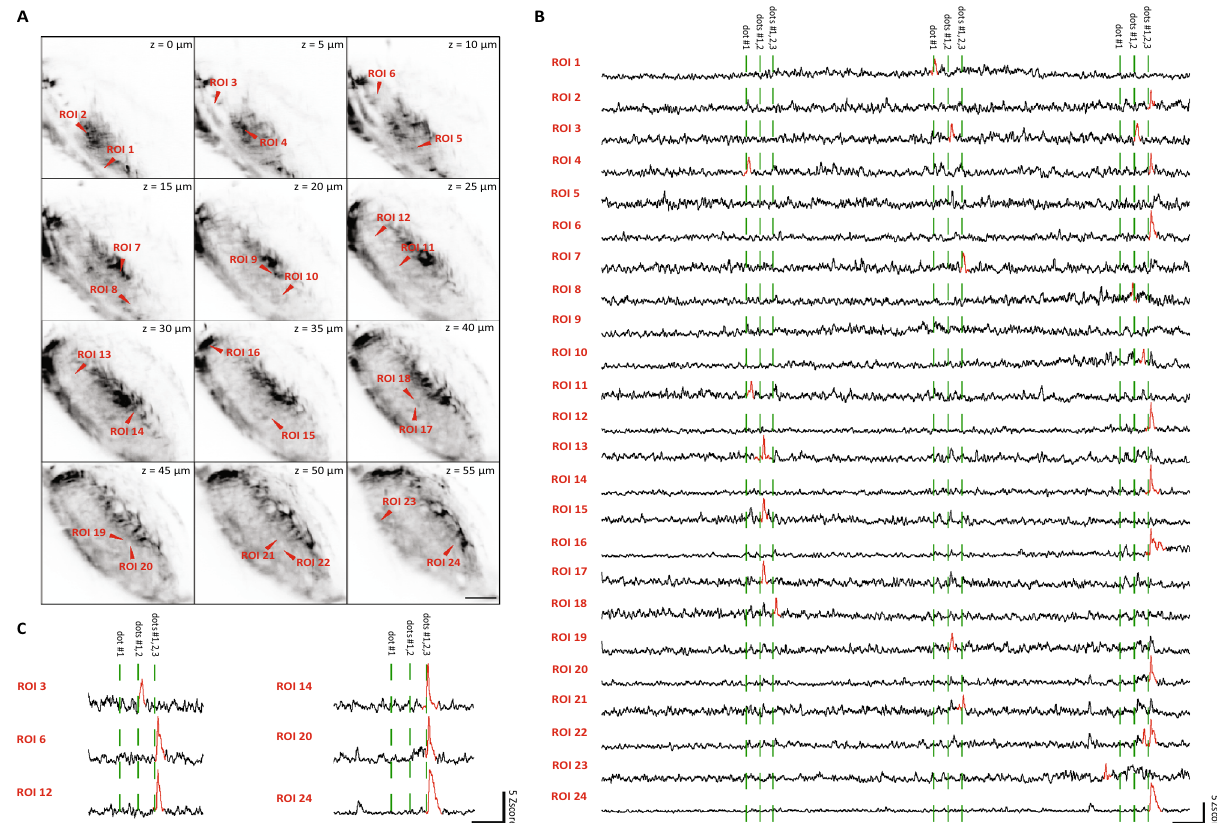
Figure 3. Multiplane calcium imaging of the RGC arborization fields. ( A ) Average intensity projections of the planes acquired across the RGC arborization fields. Red arrowheads indicate the regions of interest (ROIs) corresponding to single pixels identified. Scale bar = 20 μm. ( B ) The profiles of activity for the identified pixel in response to visual stimuli. Spikes with the peak exceeding a z-score of 5 are indicated in red. ( C ) Trace details of a subset ROIs during the last series of visual